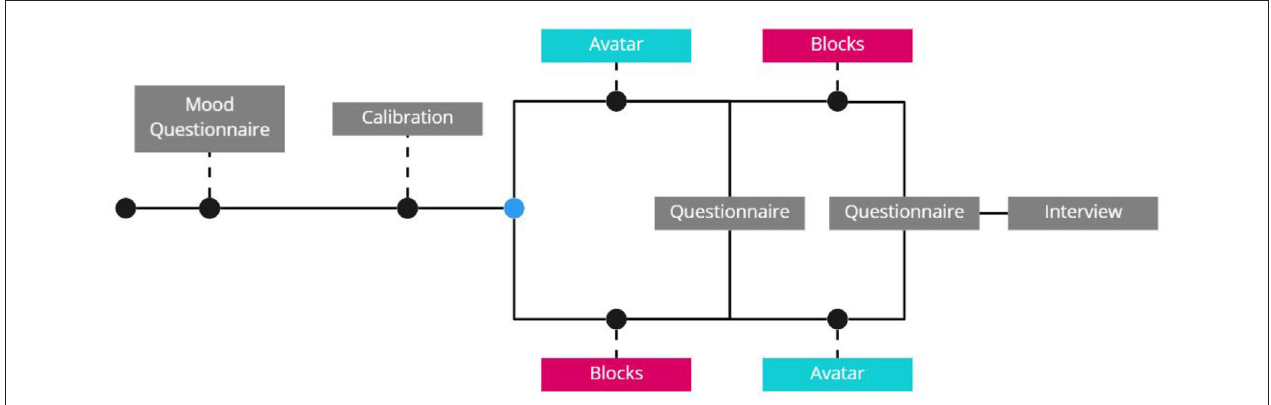
FIGURE 3 | The procedure for the experiment started with the Mood questionnaire (Skola and Liarokapis, 2018), and equipping the EEG and VR headset. Afterwards the participants were allocated by order into each level and given a questionnaire after each condition followed by a debrief